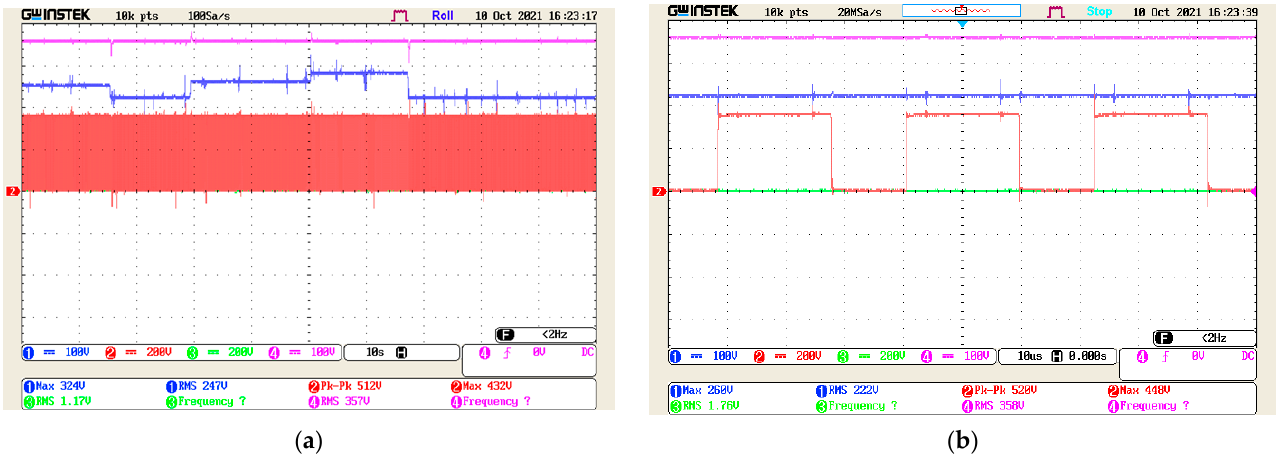
Figure 12. EKF MPPT control of two − phase IBC: ( a ) input voltage (blue line), output voltage (pink line), G-S switching signal (red line); ( b ) zoomed views.